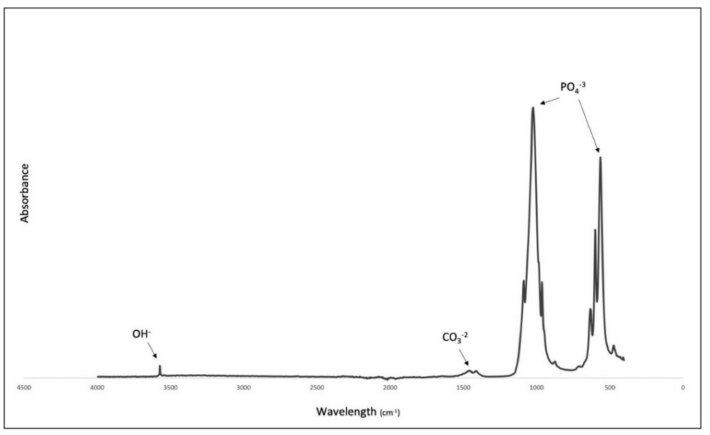
Figure 3. FTIR spectra of